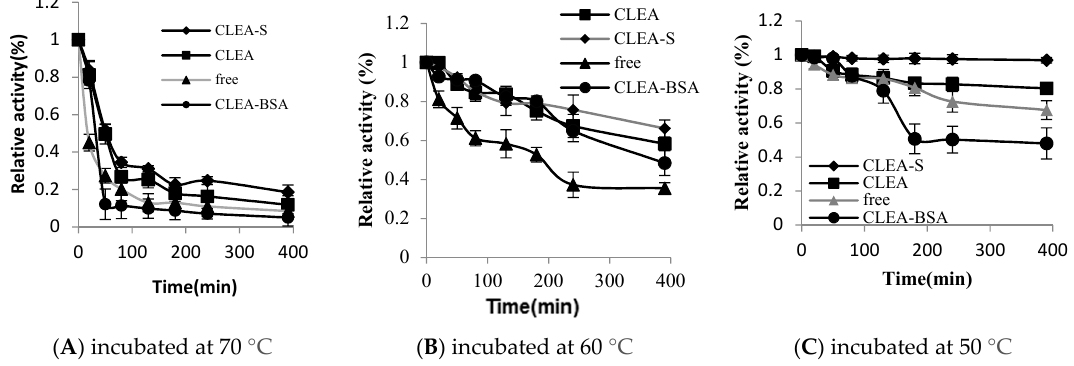
Figure 4. Comparison of thermal stability of four types of α -amylase. Solution starch 2% ( w/v ) in 100 mM phosphate buffer (pH 7.0) was incubated with enzyme at 50, 60, and 70 °C, respectively. Rates of hydrolysis are expressed as percentage of the maximal activity.